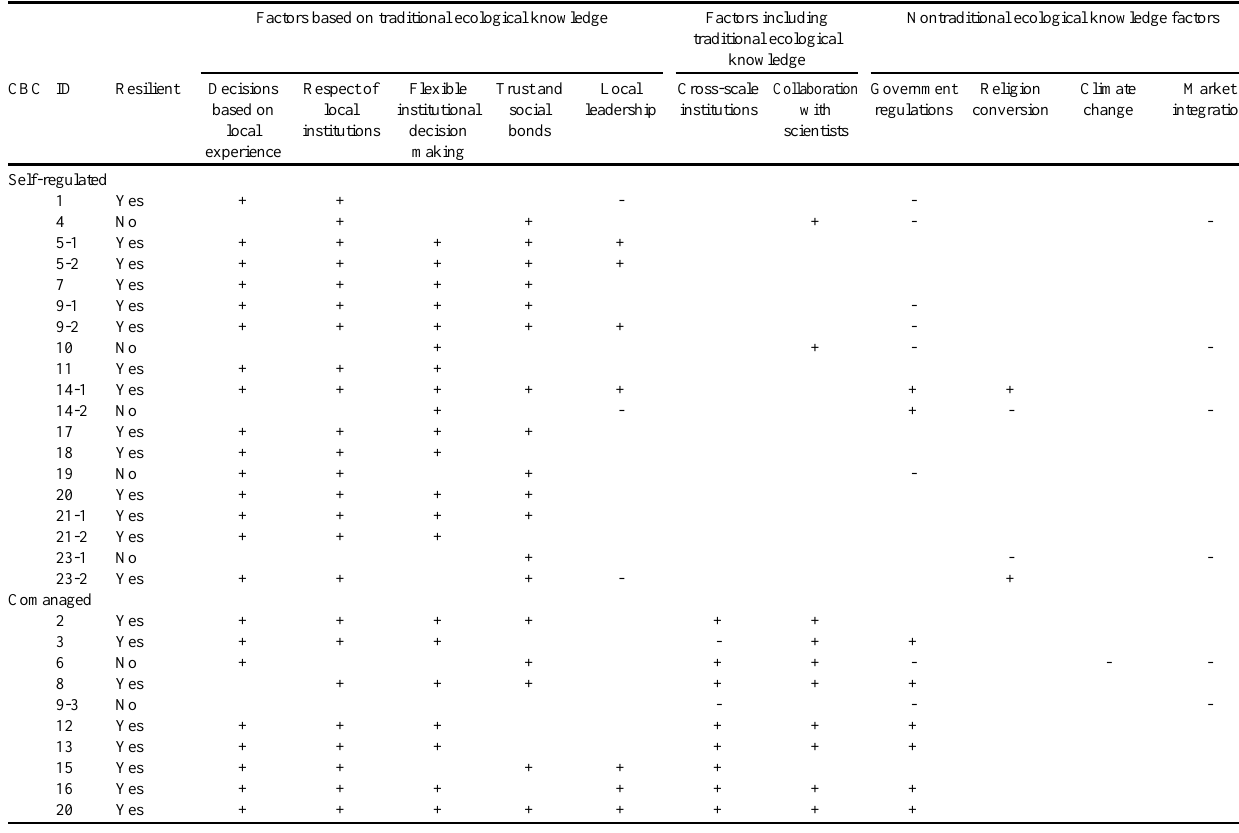
Table 3 . Reported factors enhancing resilience (+) and undermining resilience (-) in the context of community-based conservation (CBC) initiatives, by type of community-based conservation governance